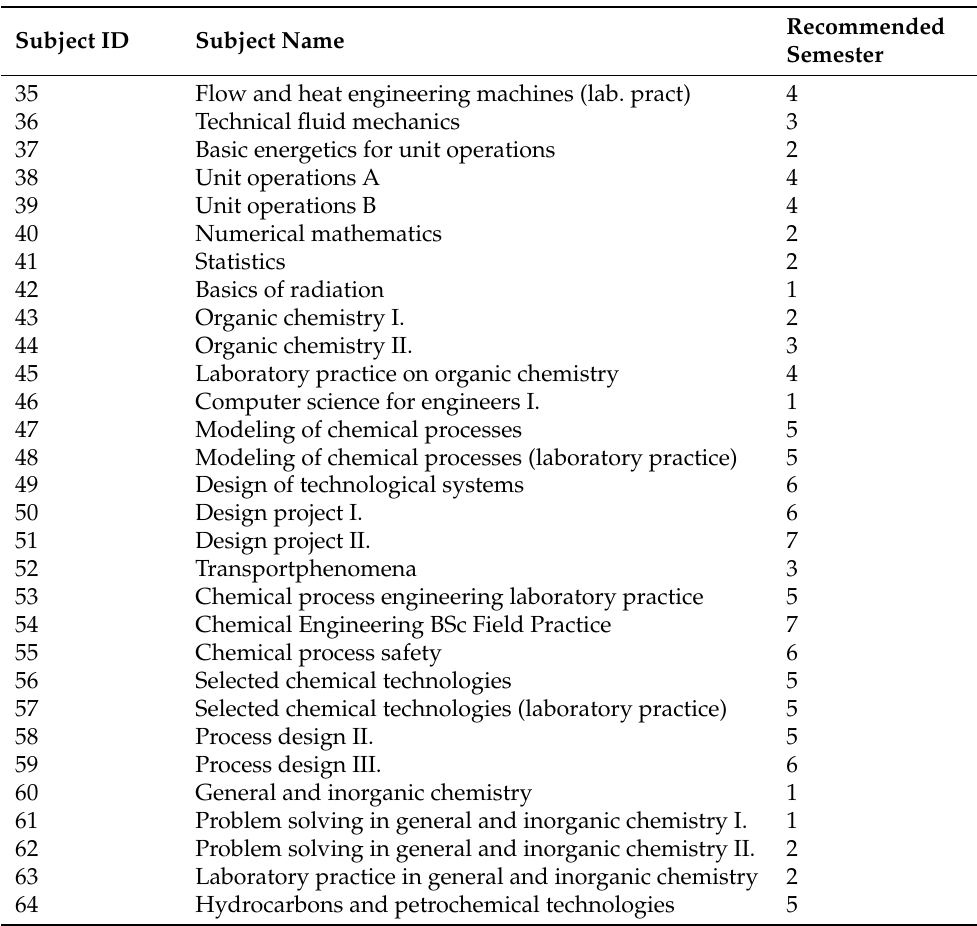
Table A2. Summary of the Identifiers, Names Used in the Study and the Number of Recommended Semesters of Subjects According to the Sample Curriculum part